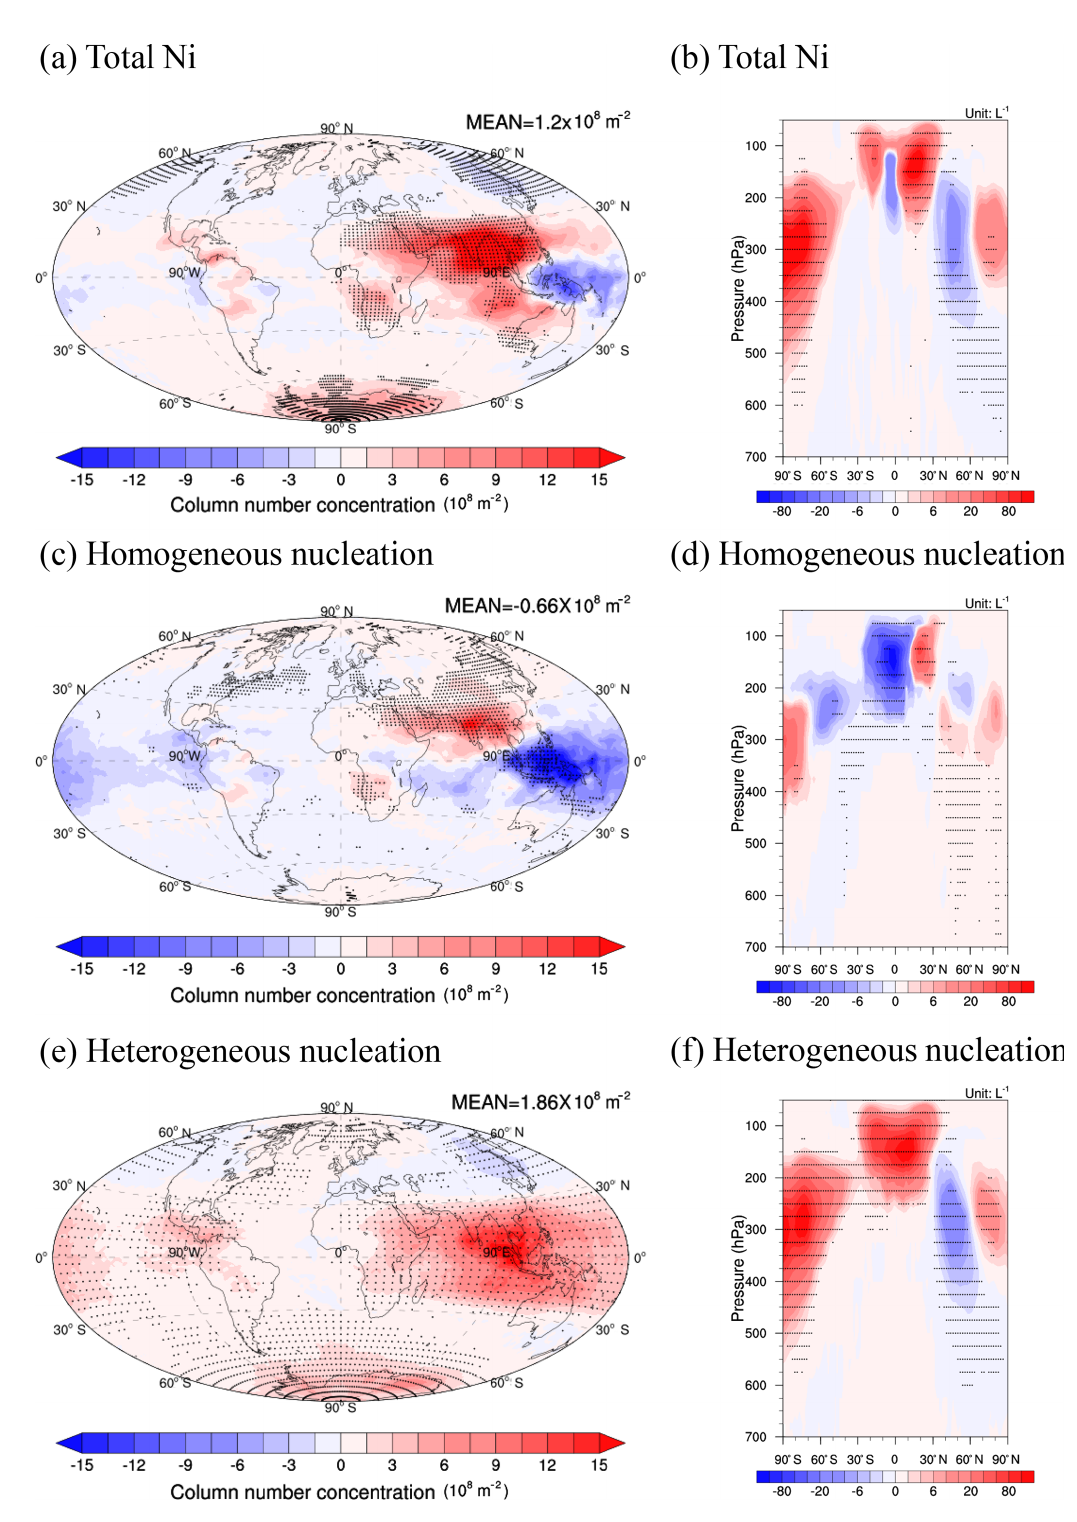
Figure 11. The annual average change in column number concentration (a, c, e) and zonal average number concentration (b, d, f) of total ice (a, b) , ice from homogeneous nucleation (c, d) , and ice from heterogeneous nucleation (e, f) for the difference between the PD_SOA and PI_SOA cases. Differences significant at the 90% level according to a Student’s t test are depicted by